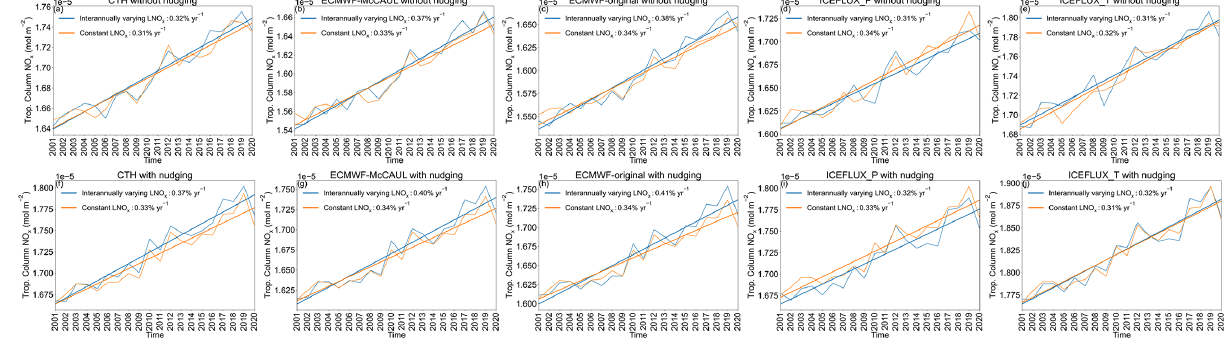
Figure 15. Trends of global mean tropospheric NO x columns calculated from simulation results (2001–2020) using different lightning schemes. Straight lines in the figure are the fitting curves. The numbers in legends represent trends corresponding to that figure in the unit of percent per year (%yr − 1 ). Panels (a) – (e) present results obtained without nudging; panels (f) – (j) present results obtained with